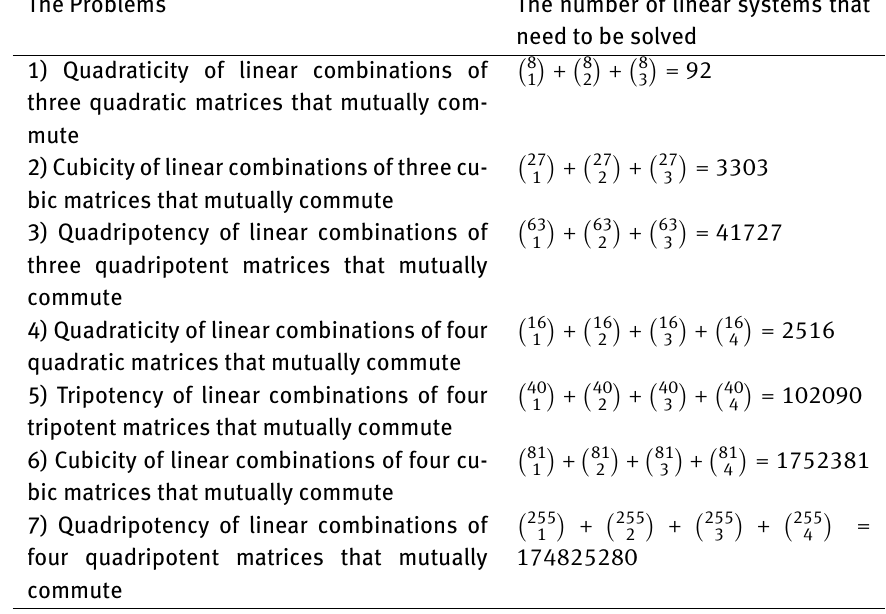
Table 3: Summary of open problems The